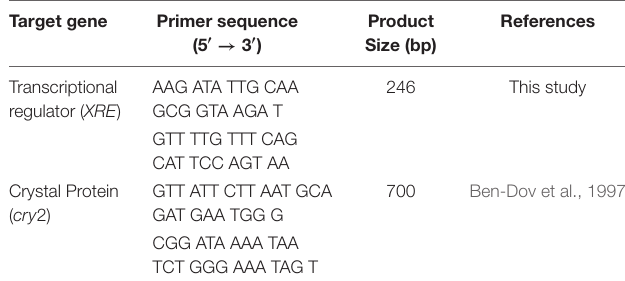
TABLE 1 | Oligonucleotide primer sequences used in this